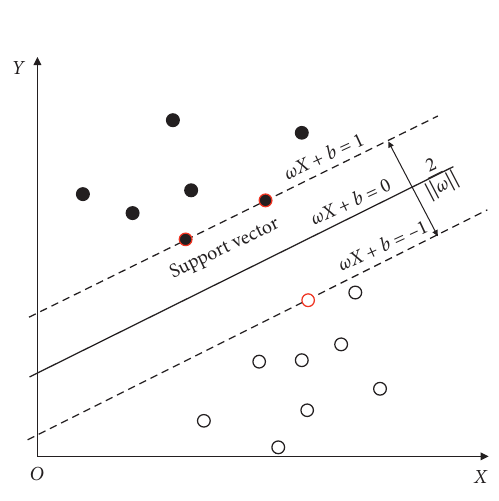
Figure 1: Schematic diagram of SVM.